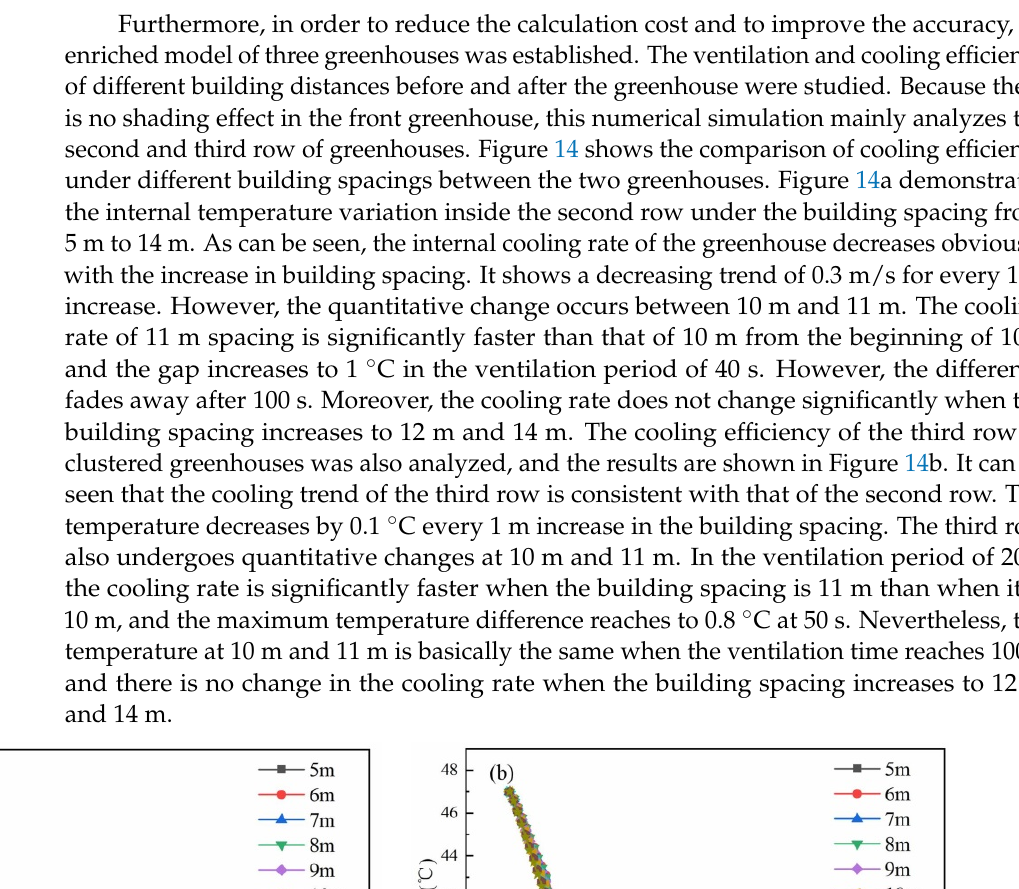
Figure 13. Flow fields of three typical cross sections under different greenhouse arrangement.